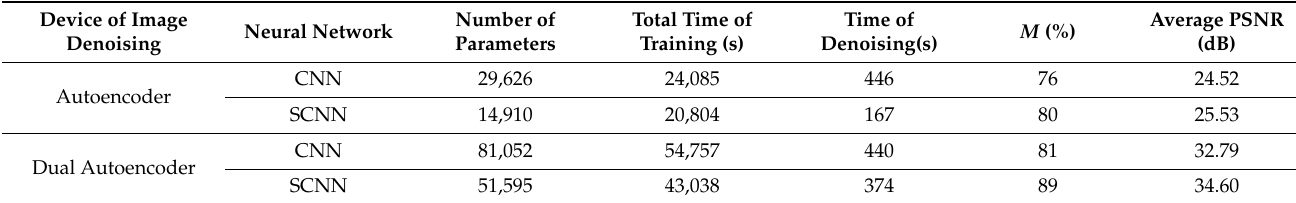
Table 1. Gaussian noise reduction.